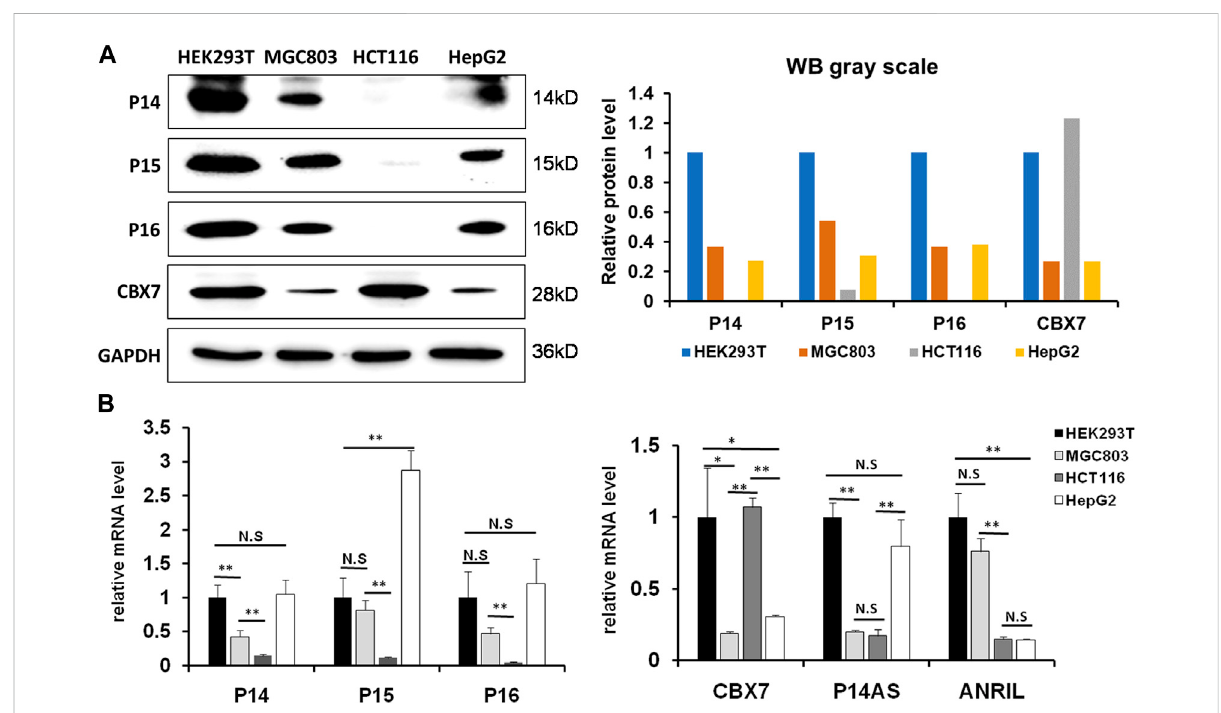
FIGURE 1 The status ofbasal CBX7, P16 INK4A , P14 ARF , P15 INK4B , P14AS and ANRIL expressioninhuman cell lines. (A) theresults ofWesternblot; (B) qRT-PCR analyses. The relative mRNA levels are presented as mean ± SD. N.S: not signi fi cant. *: p < 0.05. **: p < 0.01 in Student ’ s t-test.